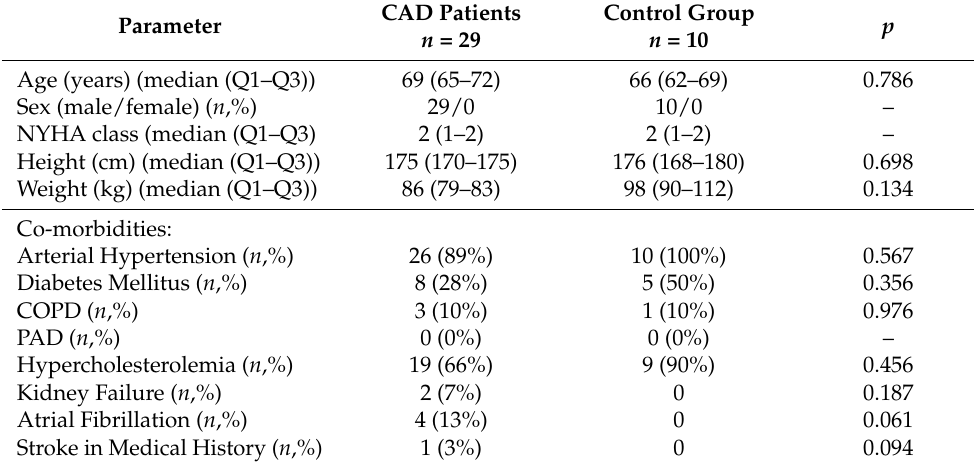
Table 1. Demographical and clinical